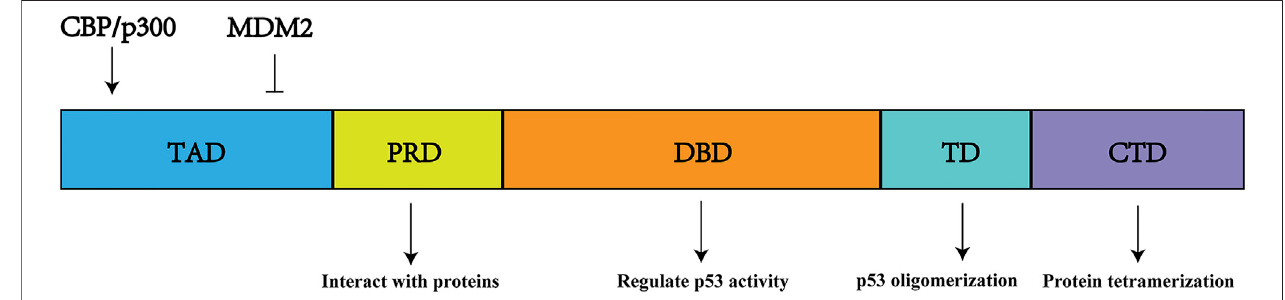
FIGURE 3 | p53 structure and function. It includes six protein domains. TAD, N-terminal transactivation domains (s); DBD, central DNA-binding domain; PRD, proline-rich domain; TD, a tetramerization domain; CTD, C-terminal